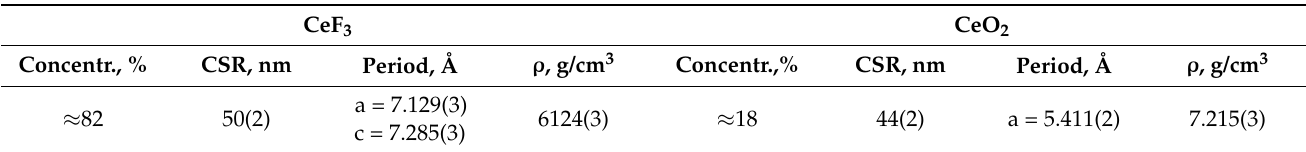
Table 2. Crystal lattice parameters and CSR dimensions of the hexagonal phase of the CeF 3 and cubic phase CeO 2 in the sample